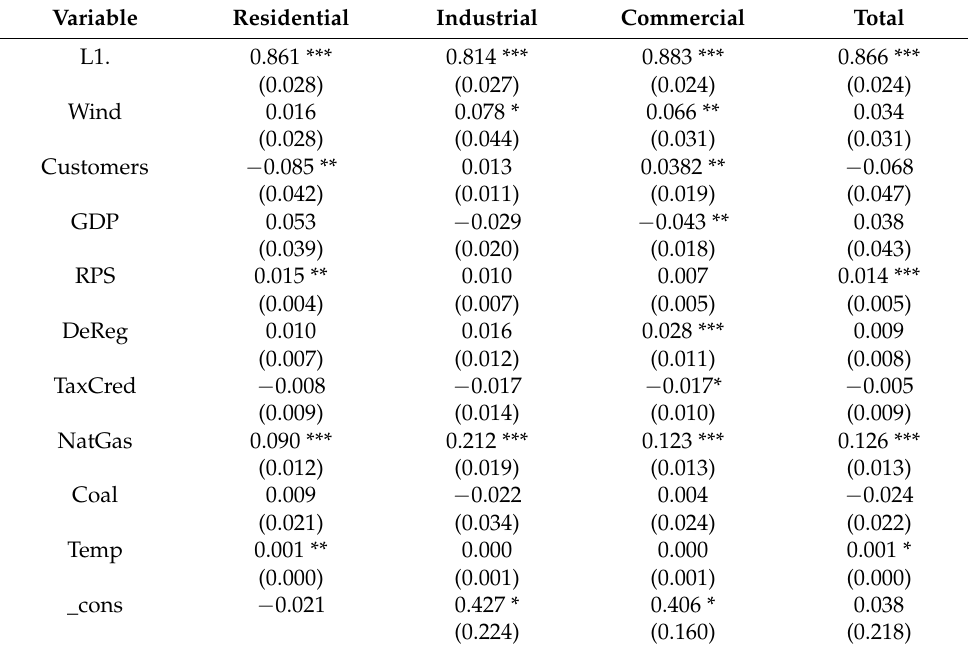
Table 3. General method of moments model. Electricity price dependent